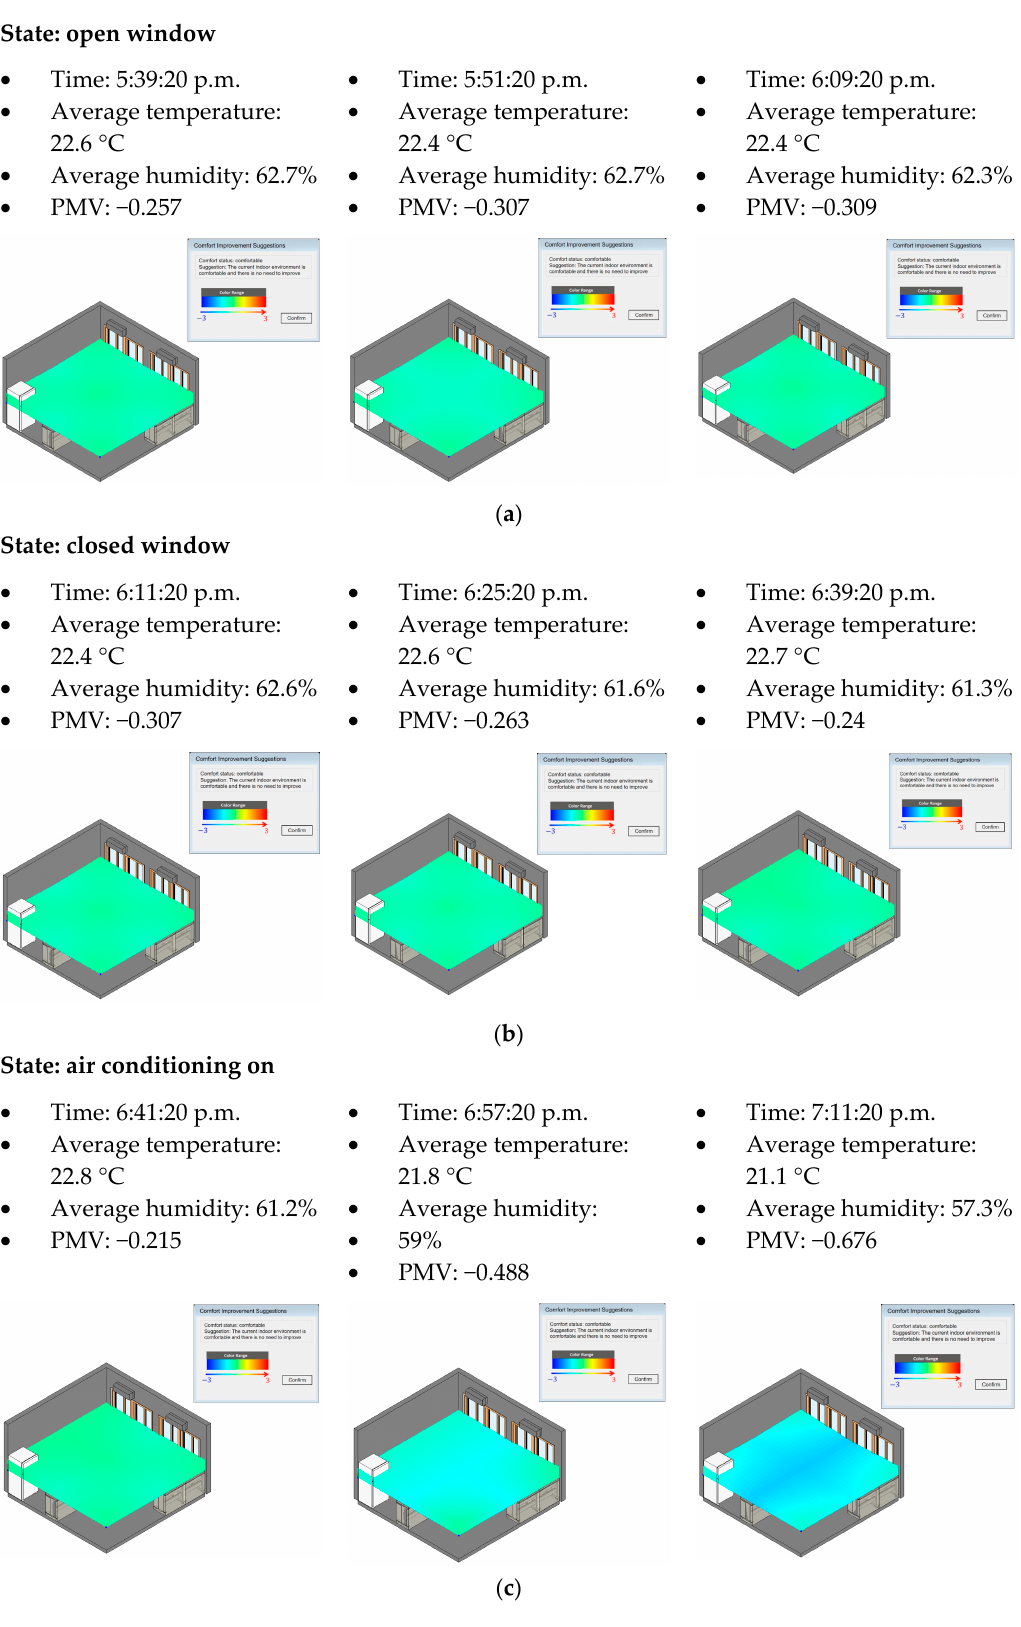
Figure 17. ( a ) PMV visualization results for the open-window state; ( b ) closed-window state; and ( c ) air conditioning-on state.